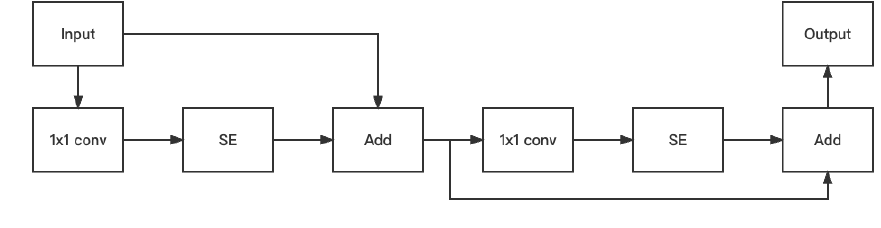
Figure 5. SE Fusion Block.